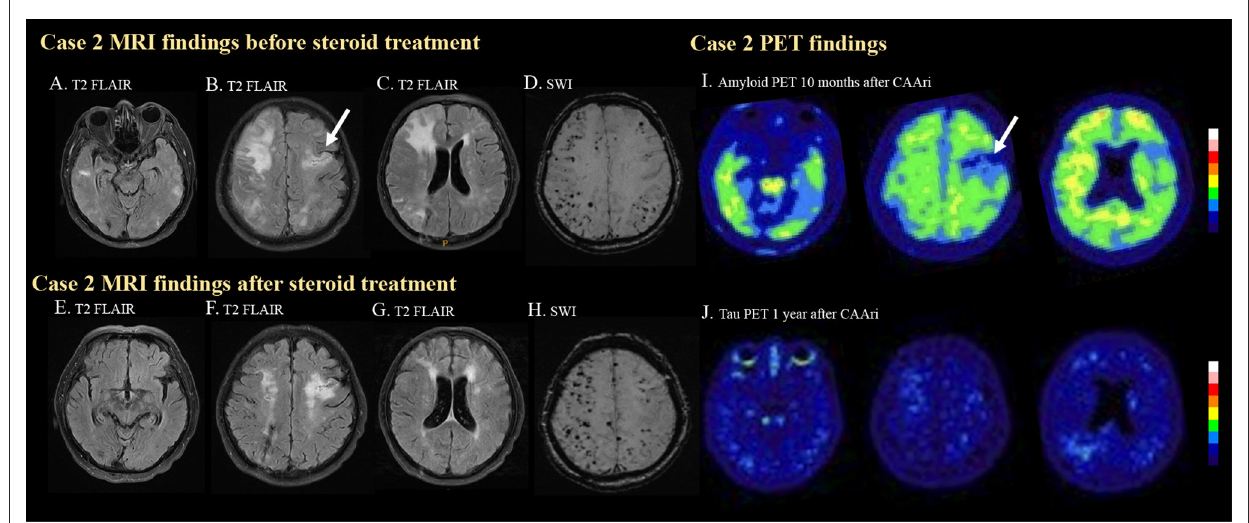
FIGURE2 MRI and PET images for case 2. In the second case, multiple hyperintense foci in the bilateral temporal lobes (A) and cortical and subcortical edema in the right frontal and bilateral parietal regions (B, C) were observed on T2 FLAIR imaging before steroid treatment. Previous ischemic insult was also demonstrated [ (B) , arrow]. Multiple strictly lobar microbleeds were detected in the bilateral cerebral hemispheres on SWI. (D) Follow-up T2 FLAIR imaging after steroid treatment showed resolution of the aforementioned edematous changes and hyperintense foci (E–G) . The microbleed became more prominent after the CAA-ri (H) . Amyloid PET confirmed amyloid deposition at 10 months after CAA-ri, but the uptake pattern did not correlate with the regions of FLAIR hyperintensities (I) . Tracer binding was not observed in the regions affected by previous ischemic insults [ (I) , arrow]. No significant tau deposition was observed on a tau PET scan (J)